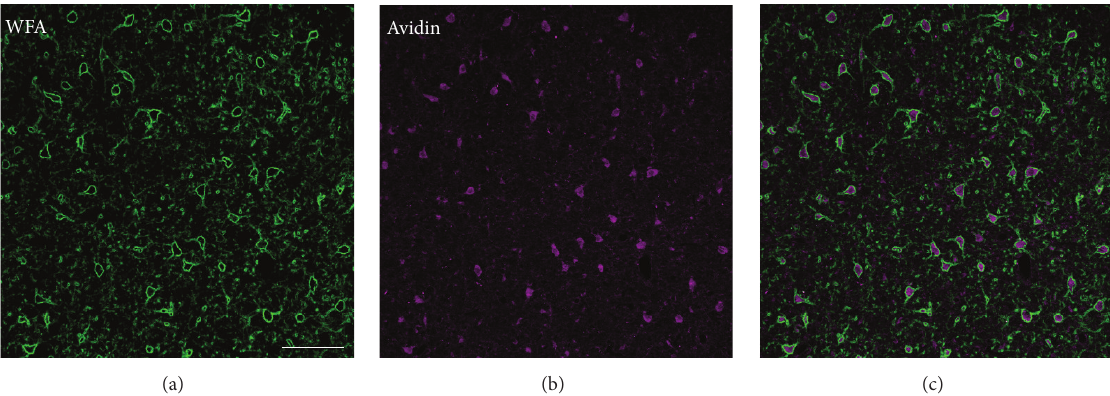
Figure 6: Perineuronal nets in the cerebellar nuclei. (a) shows perineuronal nets stained with WFA. (b) shows avidin-labeled neurons. (c) shows merged images of the two. Scale bar = 200 𝜇 m. Note the high proportion of avidin-labeled neurons (pink) surrounded by PNNs (green).